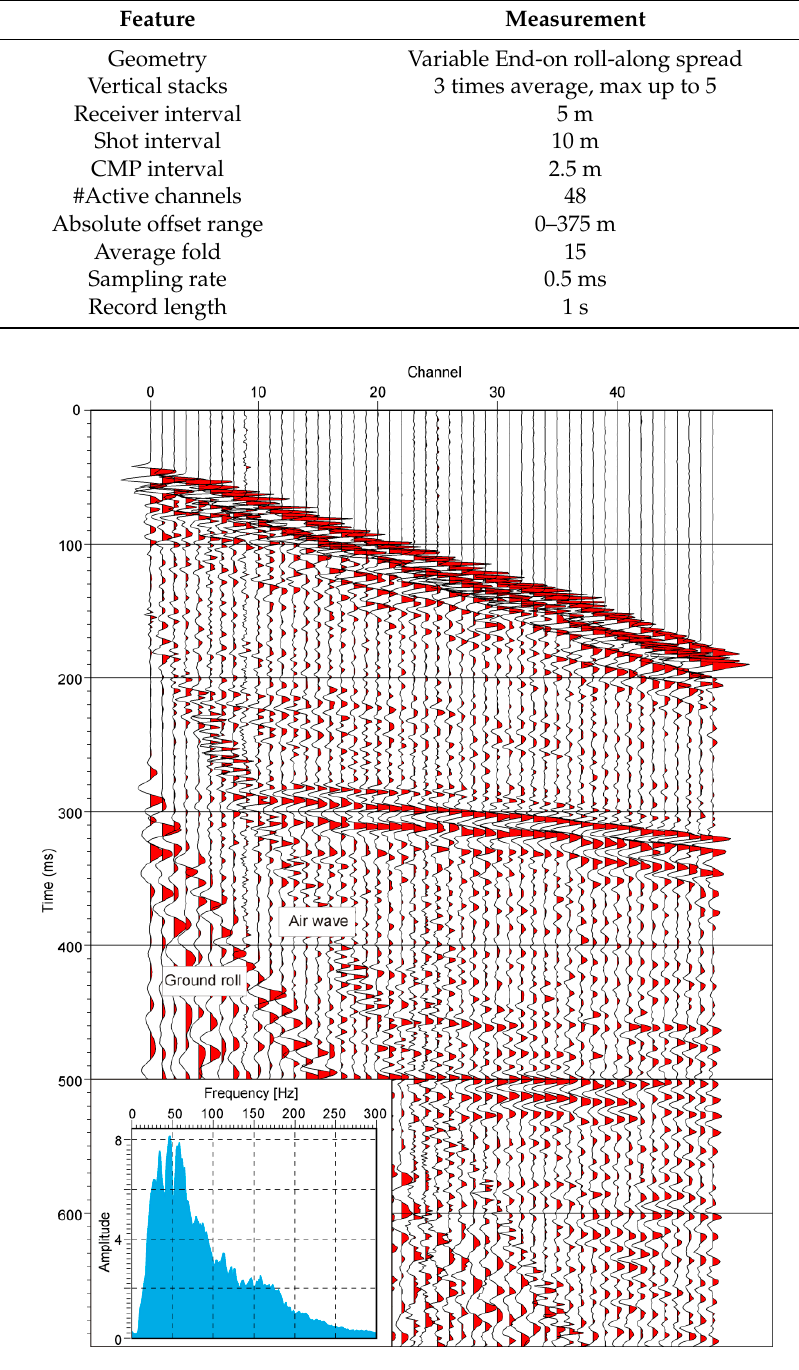
Figure 3. Example of shot gather after automatic gain control (for display purposes only) and its amplitude spectrum for the source position 50 m before the first receiver. The coherent noises (ground roll and airwave) are recorded at times below reflections from the top and bottom of the carbonate of the Miocene evaporitic formation that occur at 280